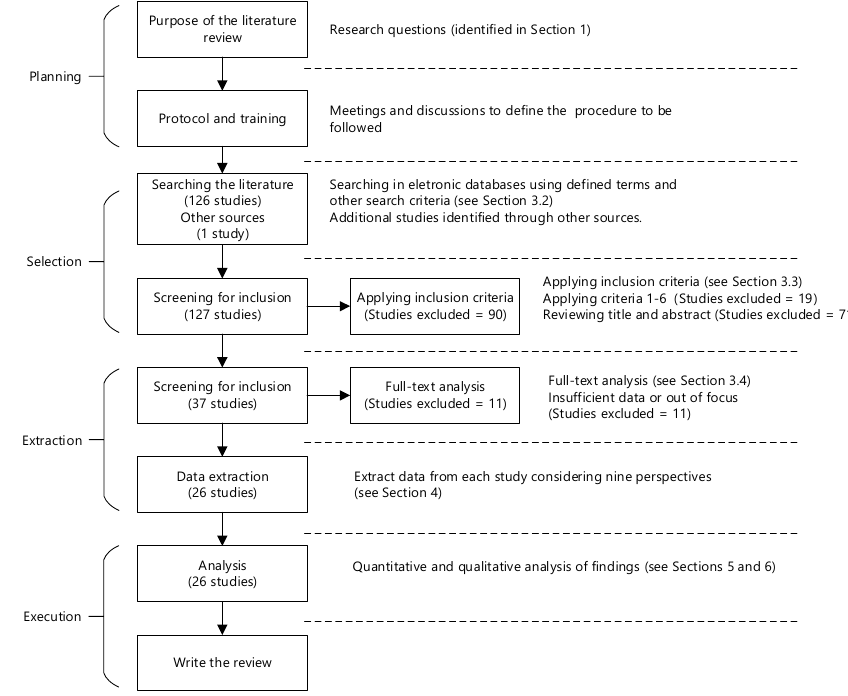
Figure 1. Flowchart of the systematic review process.